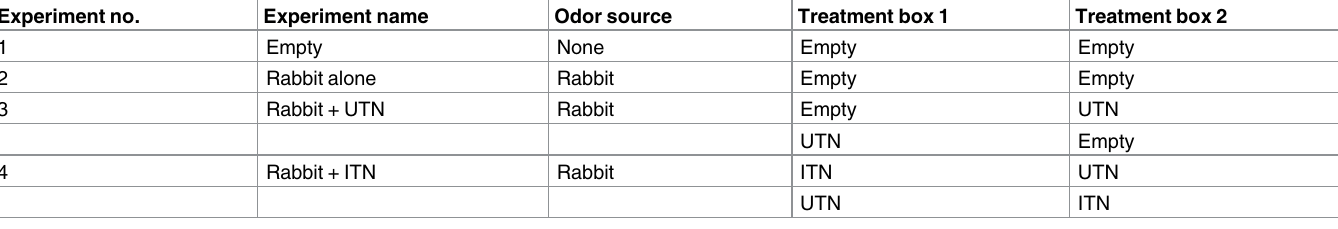
Table 1. Description of the experimental design. Experiment